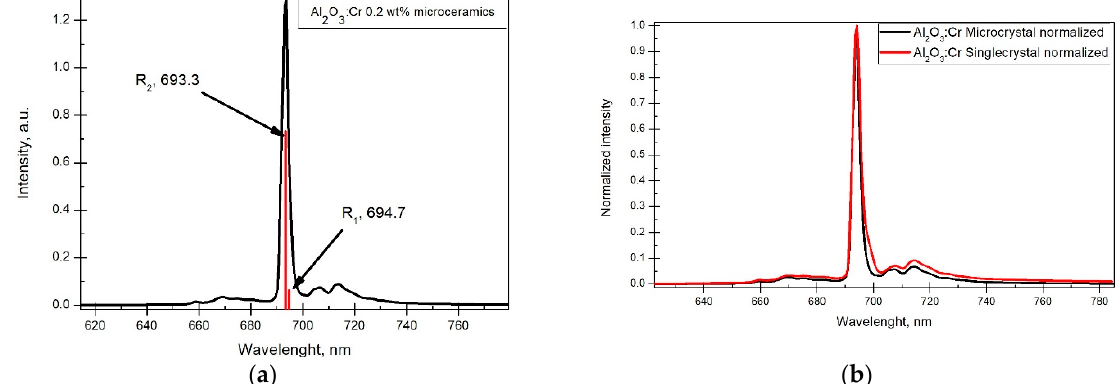
Figure 4. X-ray excited luminescence spectra for ( a ) Al 2 O 3 : Cr microparticles; ( b ) normalized Al 2 O 3 : Cr microparticles and ruby single crystal. No notable di ff erences can be observed between two sample spectra. In both cases, no emission lines were registered from 300 nm to 650